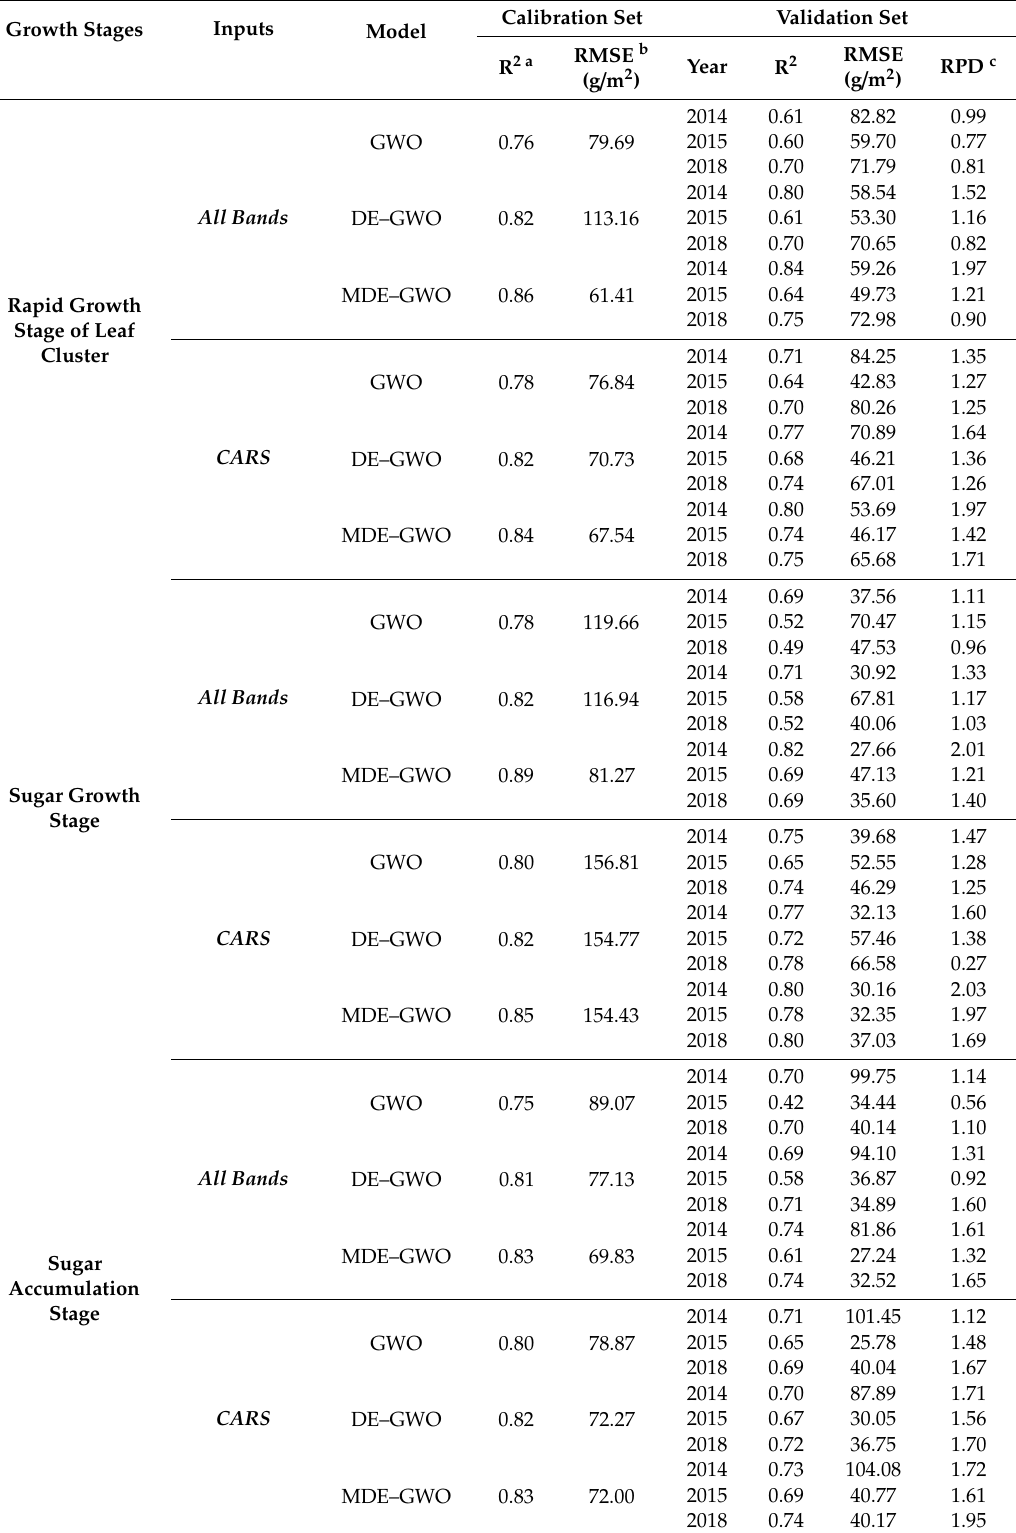
Table 5. The results of support vector machine (SVM) prediction of above-ground biomass (AGB) for each growth stage, after grey wolf optimization (GWO), di ff erential evolution grey wolf optimization (DE–GWO) and modified di ff erential evolution grey wolf optimization (MDE–GWO) algorithms. Growth